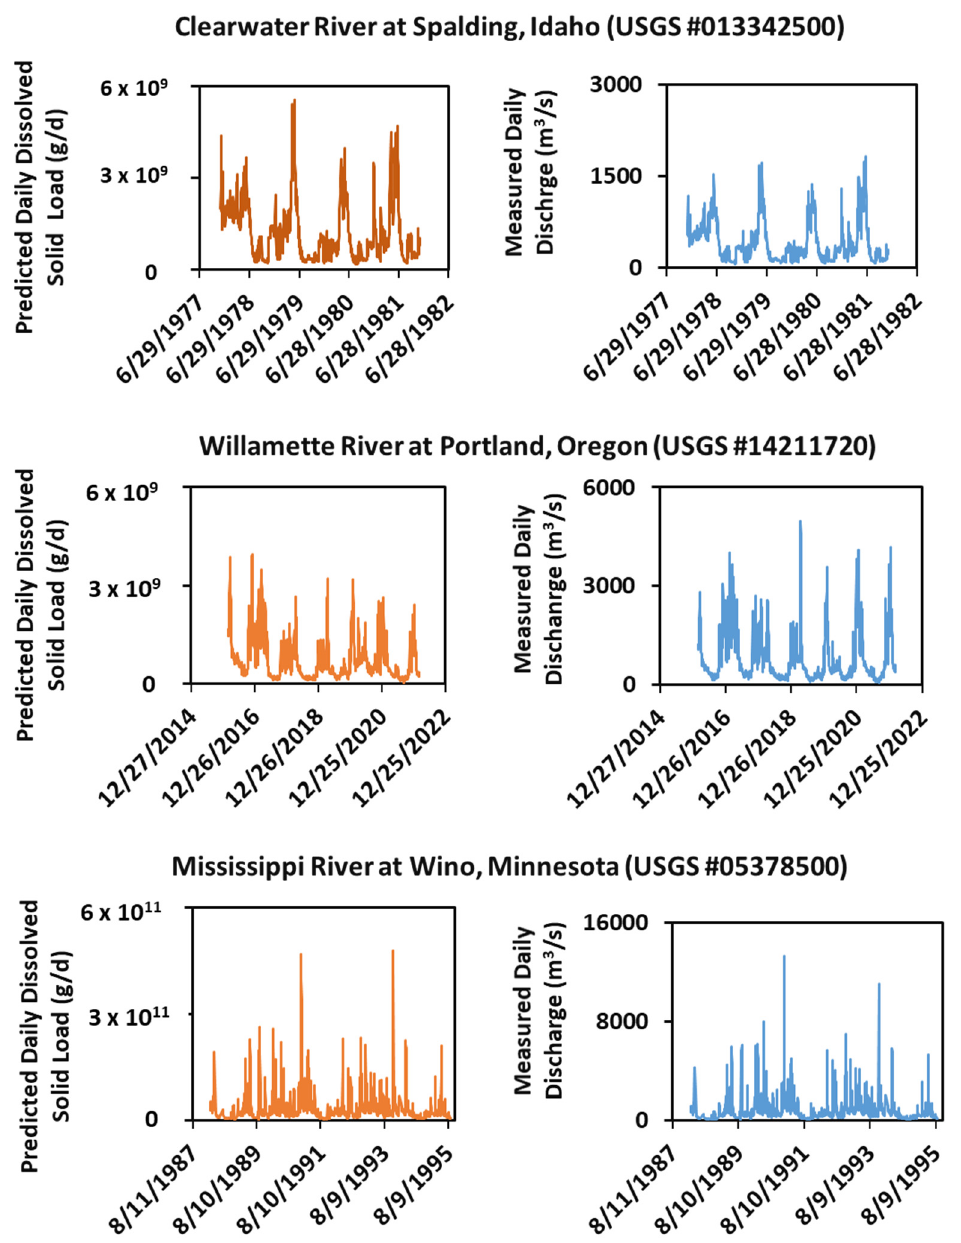
Figure 7. Predicted daily sediment loads and their corresponding measured daily discharges at Sta- tions #013342500, #14211720, and